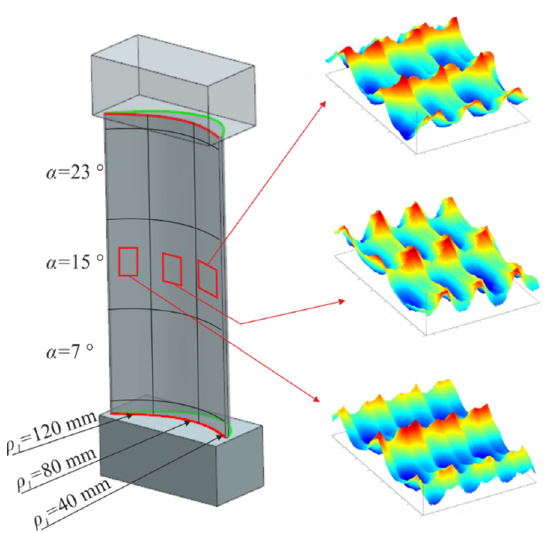
Figure 28. Topography of the concave surface when changing the curvature radius for the lead angle α = 15°.